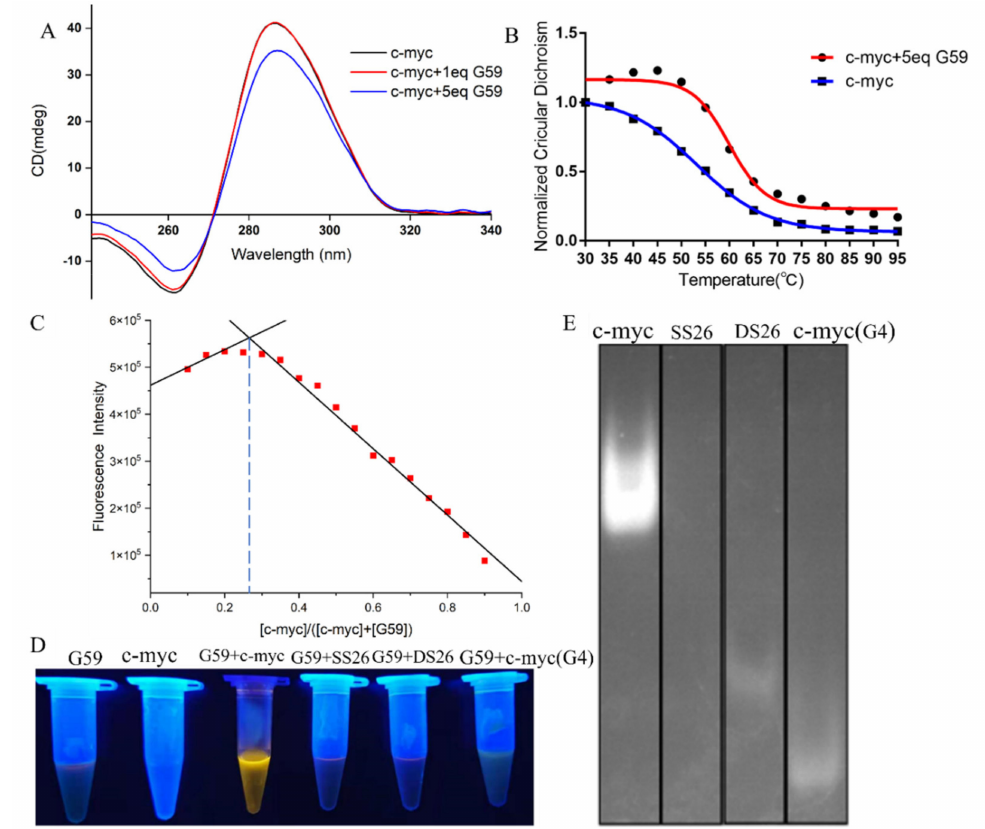
Figure 4. Binding studies of G59 with c-myc promoter i-motif. ( A ) CD spectra of 2 µ M c-myc promoter i-motif without and with 1 eq or 5 eq (2 µ M or 10 µ M) G59 in 1 × BPES buffer at pH 5.5. ( B ) CD melting curves of 2 µ M c-myc promoter i-motif without and with 5 eq (10 µ M) G59 . ( C ) The Job’s plot curve of G59 probe with c-myc promoter i-motif. ( D ) Fluorescence change in G59 with c-myc promoter i-motif and other DNAs. ( E ) Gel electrophoresis of c-myc promoter i-motif, single-strand DNA (SS26), double-strand DNA (DS26), and c-myc promoter G-quadruplex, followed by incubation using G59 probe as a staining